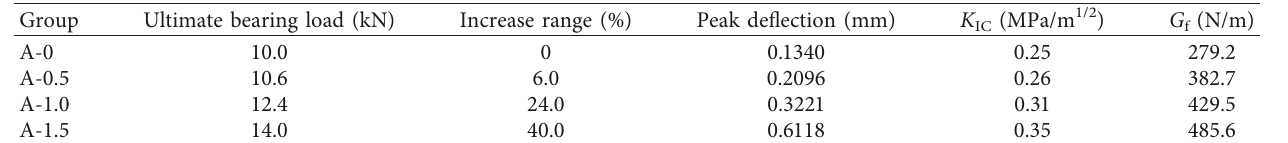
Figure 9: Specimens damaged by the wedged split tensile test: (a) plain concrete; (b) PPMFRC of 1.5% polypropylene macrofibers content. Table 7: Bending test results.